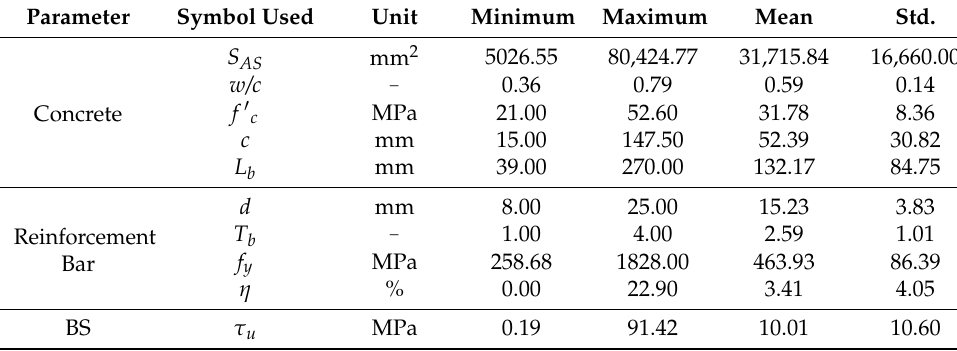
Table 3. Statistical parameters of collected